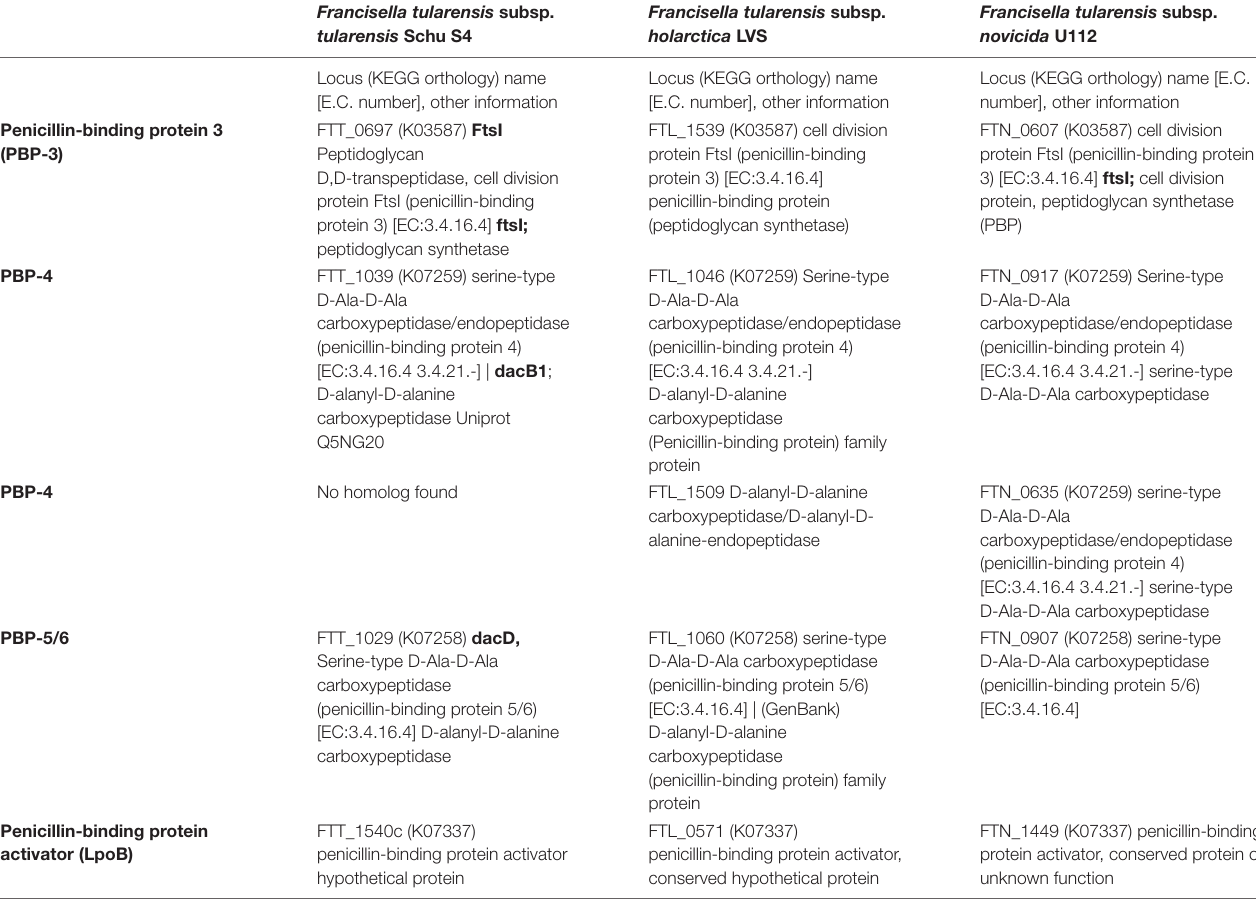
TABLE 2 | The annotated PBP gene in Francisella species and subspecies using KEGG database.